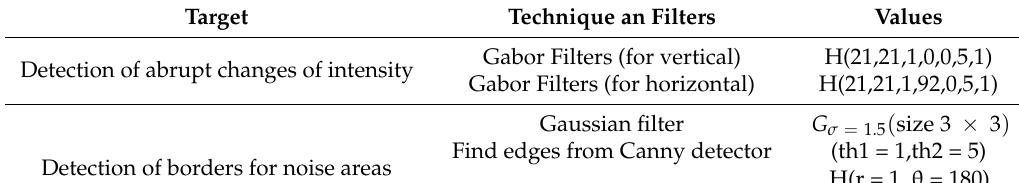
Table 2. Summary of parameters for the proposed method.